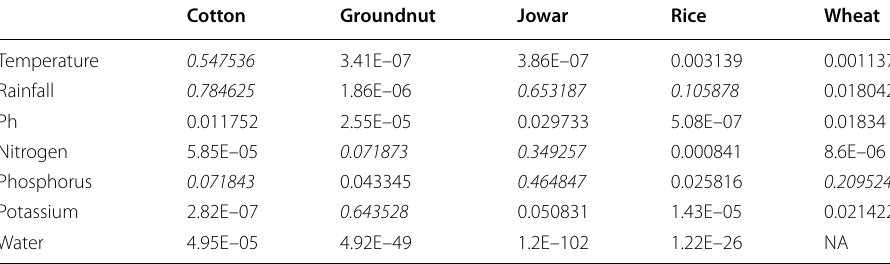
The italicized cells are representing the insignificant independent attributes for each crop as the values are more than 0.05. Regression Equation is formed using the independent variables